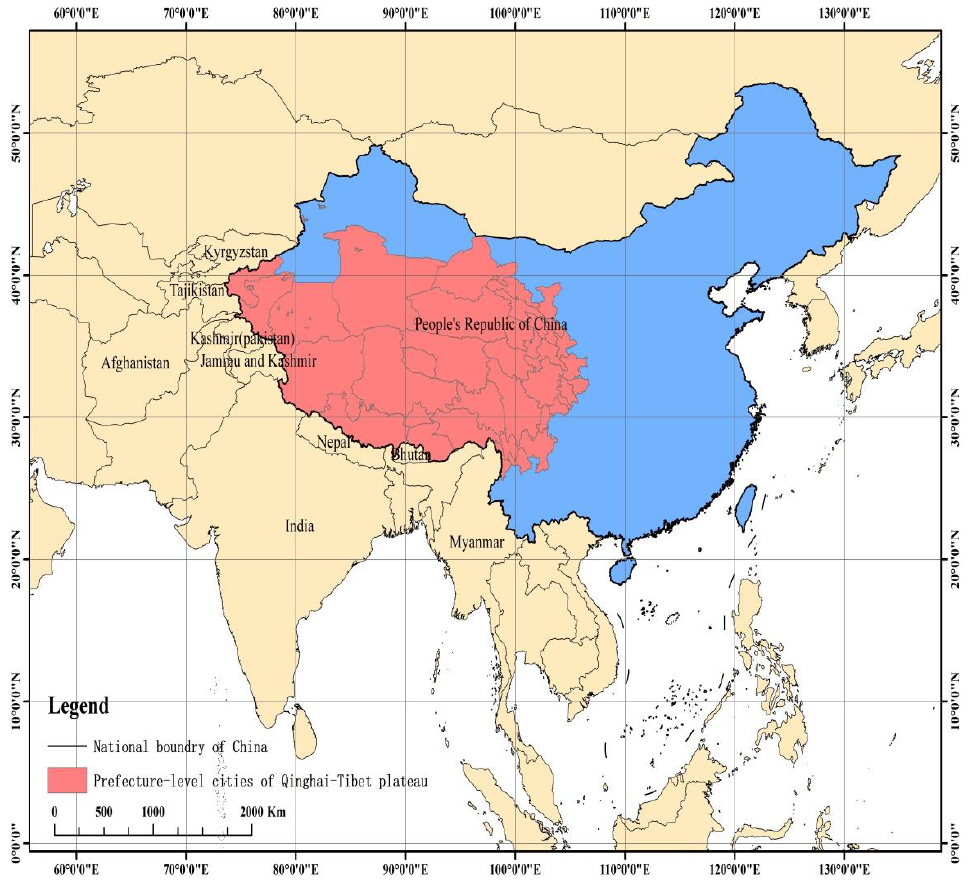
Figure 1. Sketch map of the study area.